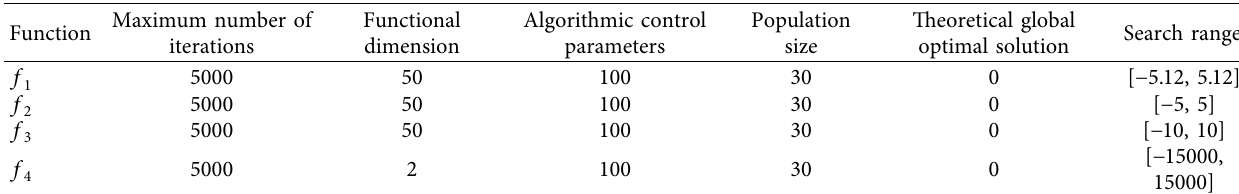
Figure 9: Three-dimensional visualization of standard test functions. Table 3: Test functions and algorithm parameter